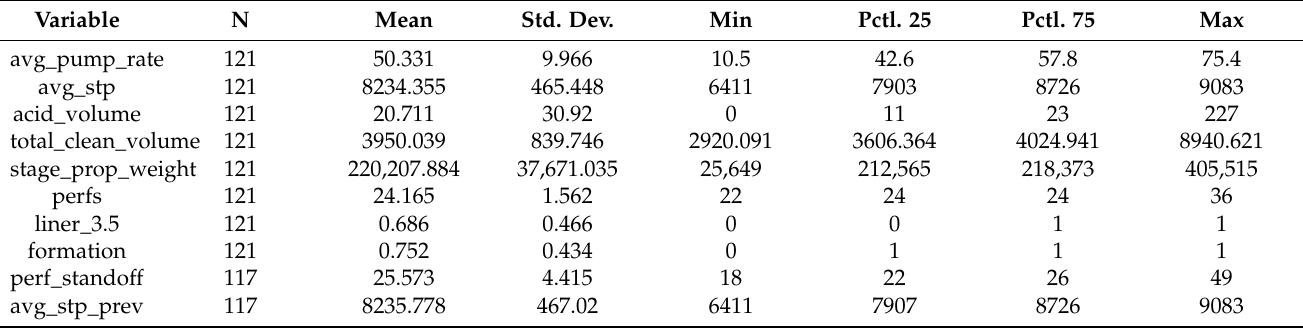
Figure 3. Cross ‐ sectional data set from re ‐ fractured wells with associated trendlines highlighting the effect of different within ‐ well characteristics.